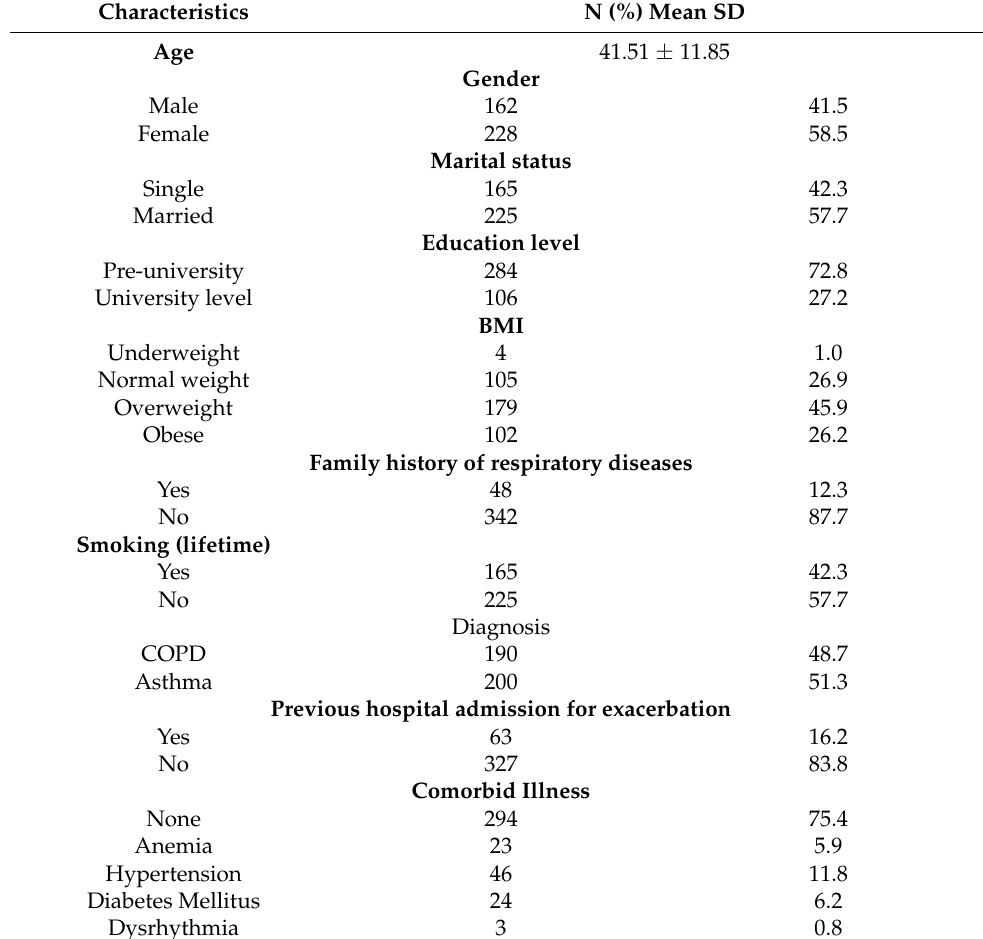
Table 1. Distribution of characteristics of patients with chronic respiratory diseases (N =